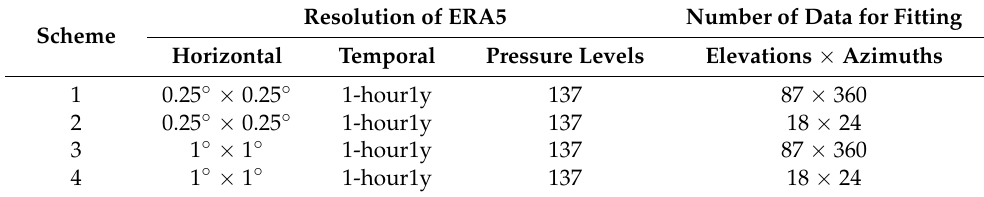
Table 1. Key parameters of the four fitting schemes.